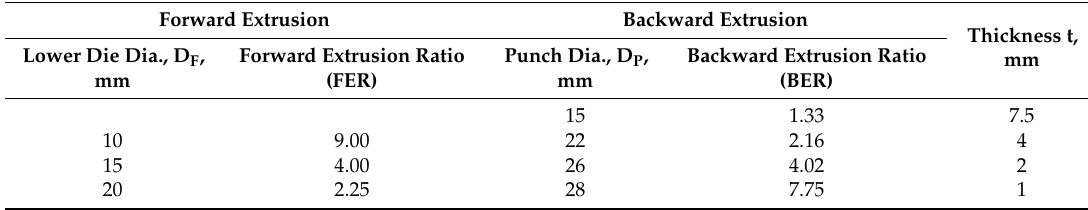
Figure 2. Geometrical parameters in a Combined Forward–Backward Extrusion (CFBE) process. Table 2. Experimental conditions for CFBE of AZ31B Mg alloy.